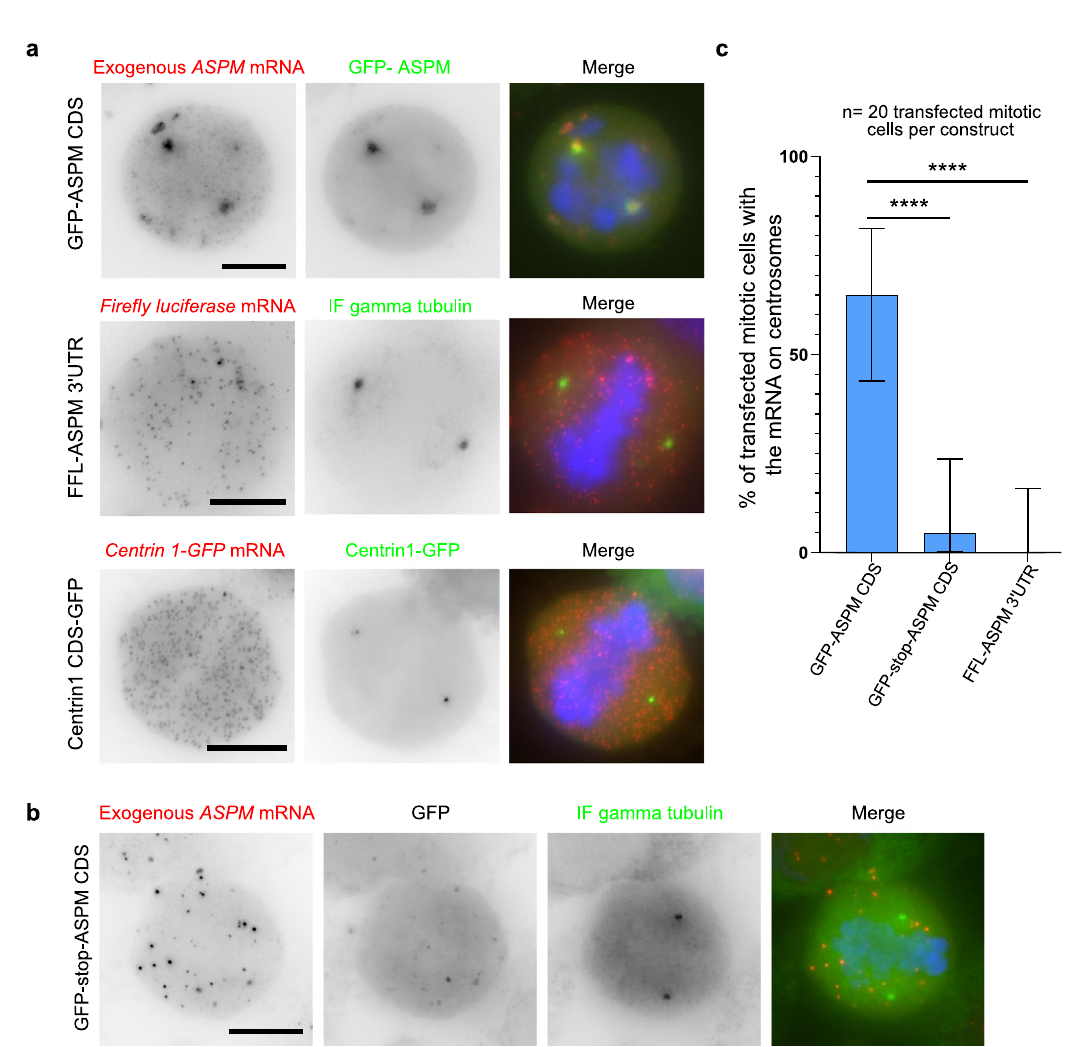
Fig. 4 Translation of the ASPM CDS is necessary and suf fi cient for its centrosomal localization. a Micrographs of mitotic HeLa cells either transiently expressing GFP-ASPM CDS, or Fire fl y luciferase CDS-ASPM 3 ′ UTR; or stably expressing centrin 1 CDS-GFP . Left and red: Cy3 fl uorescent signals corresponding to the exogenous mRNAs labeled by smFISH with probes against either the GFP or Fire fl y luciferase sequences; middle and green: GFP signals corresponding centrosomes labeled by the exogenous GFP-ASPM protein, gamma-tubulin immuno fl uorescence, or centrin1 – GFP. Blue: DNA stained with DAPI. Scale bar: 10 microns. FFL Fire fl y luciferase . b Legend as in a , but with cells expressing GFP-stop-ASPM CDS and with an IF against gamma-tubulin. DNA is shown in blue, centrosomes in green and the mRNA in red. c Bar graph depicting the percentage of mitotic cells expressing a construct and showing the centrosomal localization of the exogenous mRNA. Data were analyzed from 20 mitotic cells per construct counted from two independent experiments and expressed as a percentage of cells with localized mRNA. Binomial proportion 95% con fi dence intervals are shown in each case and were calculated using the Wilson/Brown method. Statistical signi fi cance was evaluated using a two-sided Fisher ’ s exact test. **** indicates a p value of <0.0001, and ns means nonsigni fi